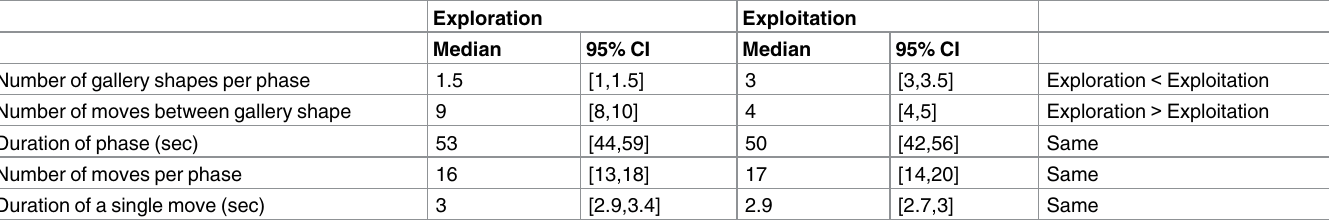
Table 1. Characteristics of exploration and exploitation phases (Medians and 95%